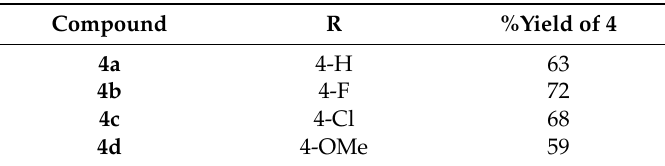
Table 3. Percentage yield of compounds 4a–d .